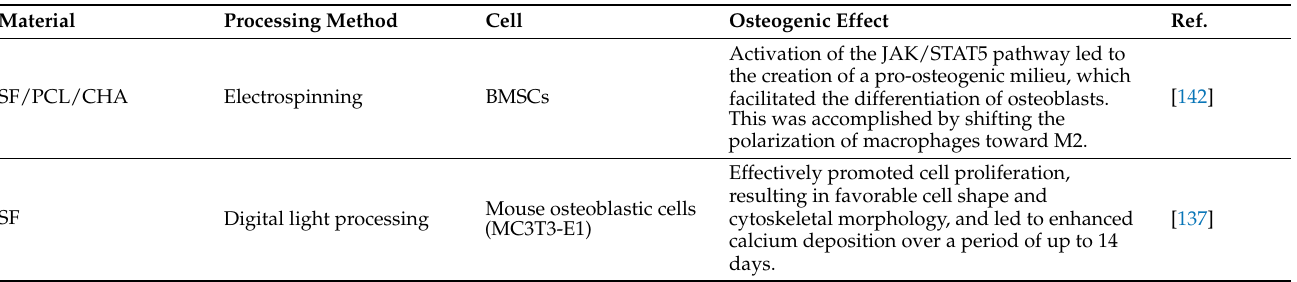
Table 1. SF-based scaffolds for BTE